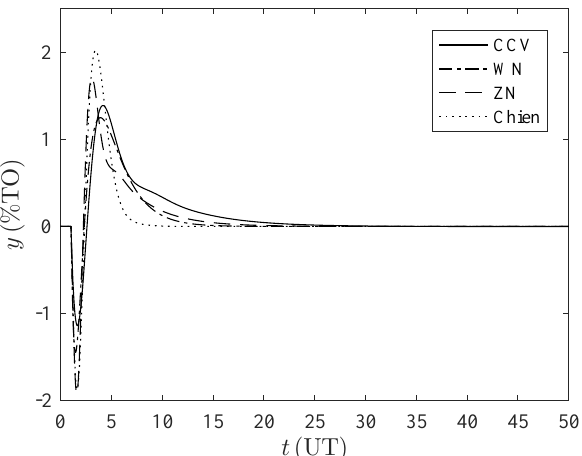
Figure A3. Time response disturbance rejection for the set P 2 . %TO: percentage of transmitter output, UT: units of